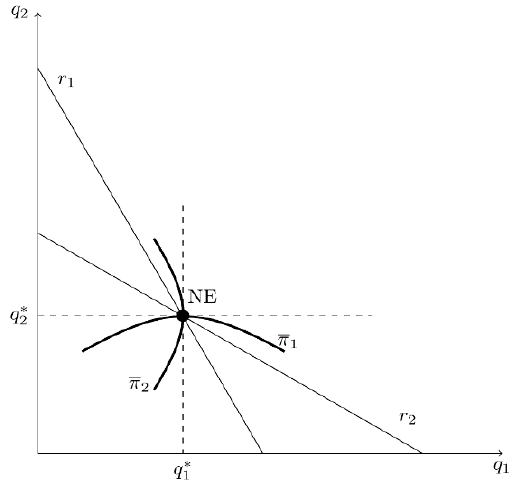
Figure 2. Best-Reply Curves, Iso-Profit Curves, and the Nash Equilibrium ( NE ) in the Simple Figure 2. Best ‐ Reply Curves, Iso ‐ Profit Curves, and the Nash Equilibrium ( NE ) in the Simple Cournot Cournot Model.